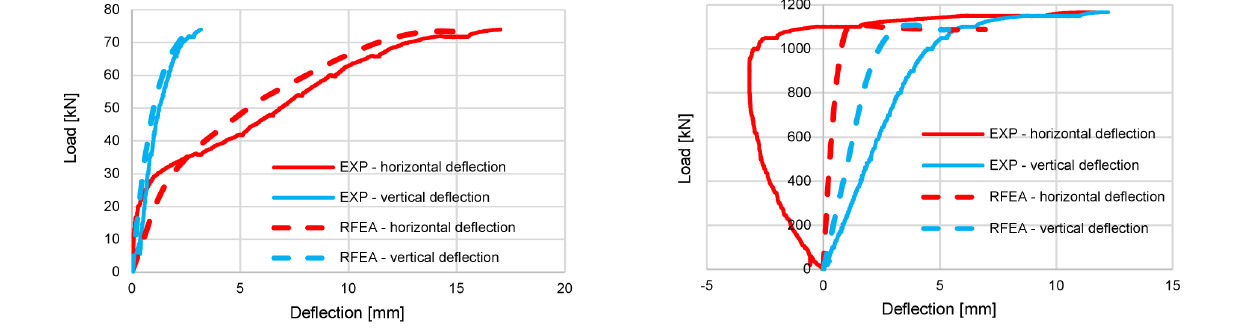
Fig. 12. Load-deflection curve for specimen C